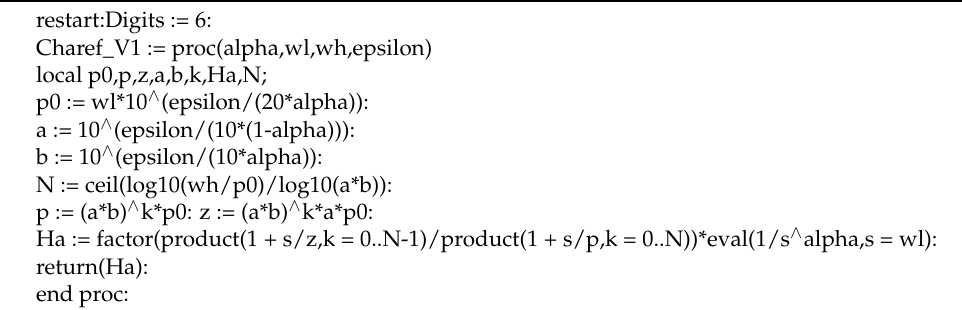
Table 8. Code in Maple 18 environment of